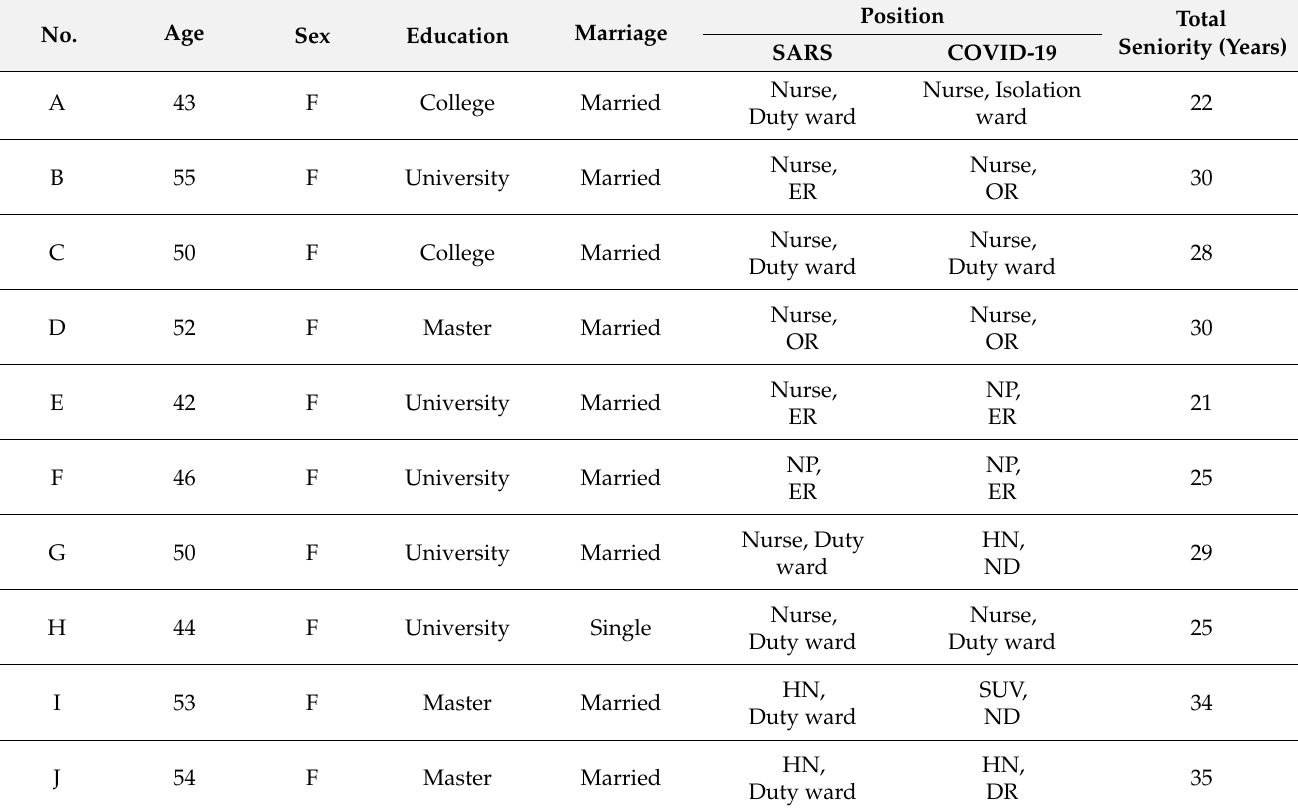
Table 1. Demographic